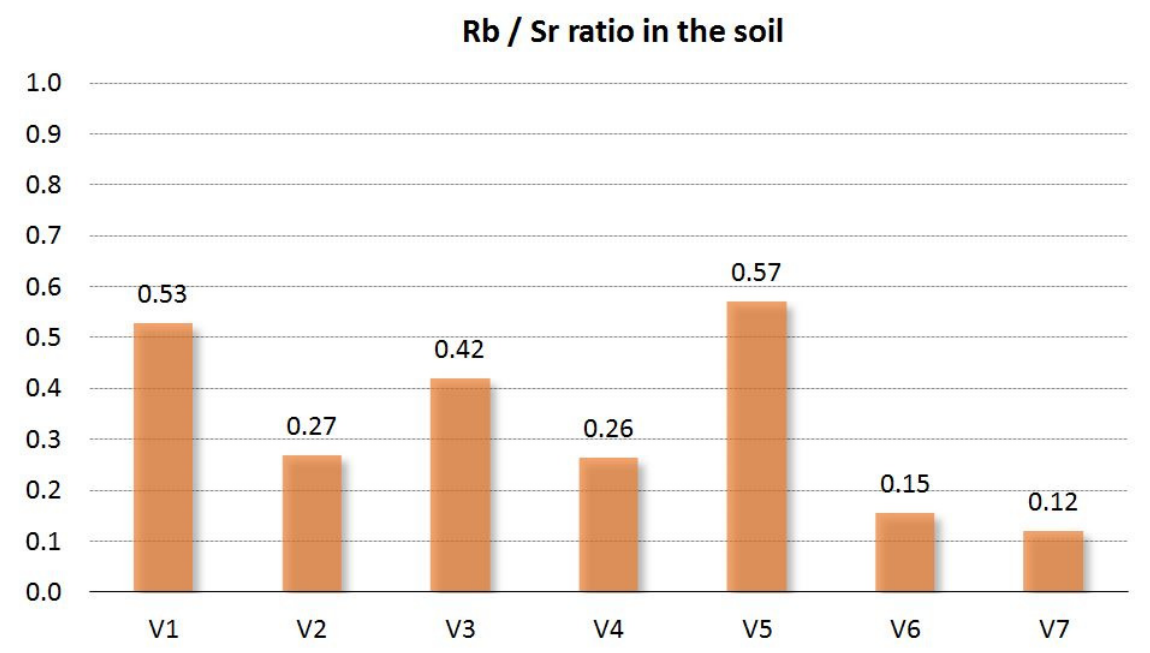
Figure 9. The analysis of the Rb/Sr ratio of radiogenic isotopes distinguishes the parent materials’ origins, even for some of the most geologically complex soils. Vineyard V5, similar to V1 and V3, has a proportion of shale and clay minerals transported from afar through ice. The Rb/Sr ratios of V2, V4 and V6 are lower due to the higher amount of dolomite (seawater and, therefore, carbonate rocks have a low Rb/Sr). In vineyard V7, the soil originates from nearby ancient sedimentary rocks. Raw data are presented in the Supplementary Material (Table S1).